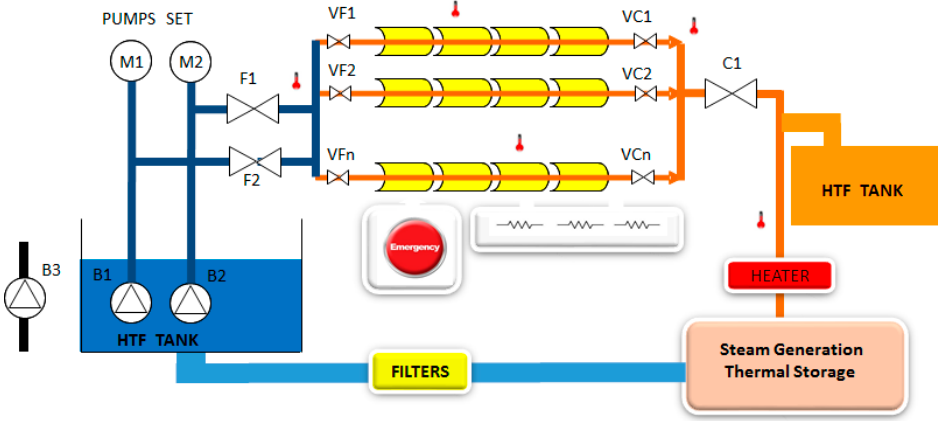
Figure 2. Simplified scheme of the heat transfer fluid (HTF) heating process.